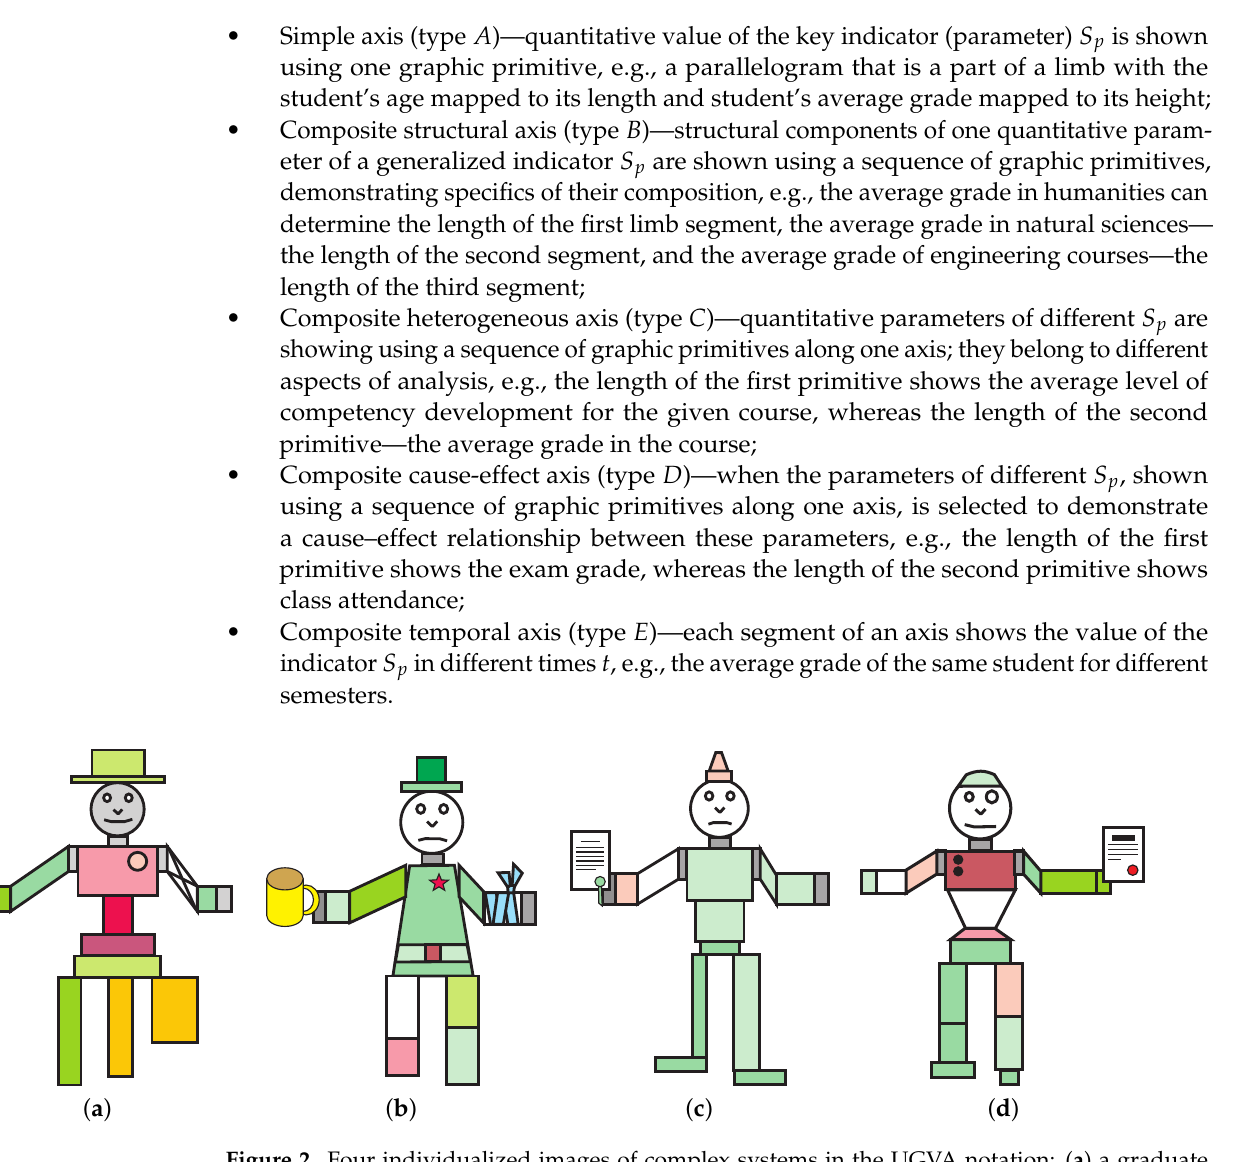
Figure 2. Four individualized images of complex systems in the UGVA notation: ( a ) a graduate student who studies courses using an online intelligent tutoring system; ( b ) an employee of a company, whose direct supervisor uses an intelligent decision-supporting system to receive advice on motivating employees; ( c ) a funding application for a scientific project according to their performance; ( d ) a laboratory researcher according to the university’s key performance indicators (KPI).